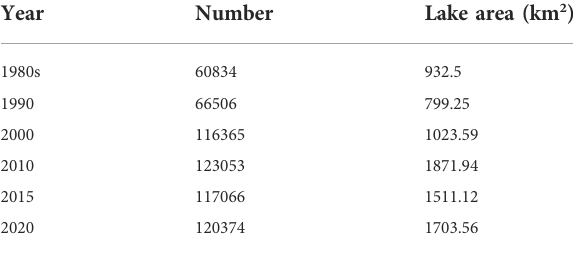
TABLE 1 Dynamics of thermokarst lakes in the QTP, 1980s – 2020.